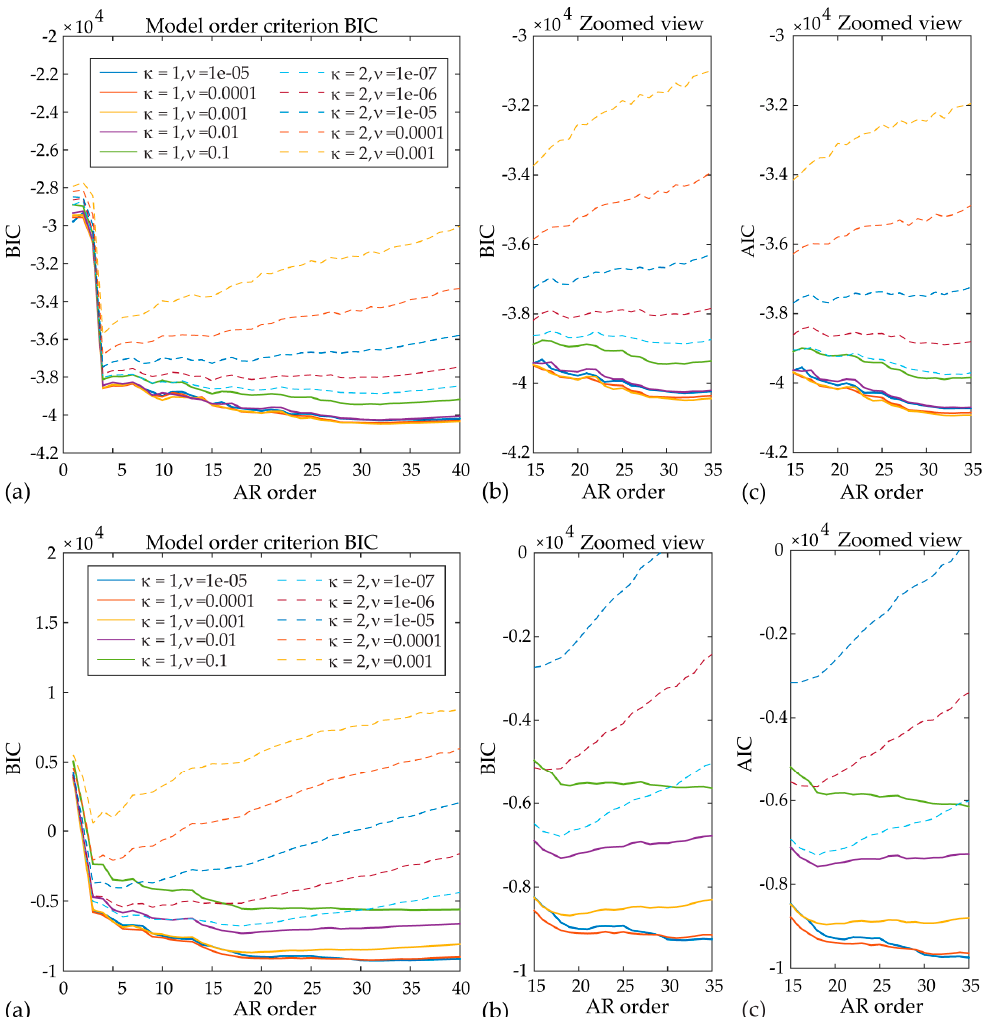
Figure 8. Statistical criterion for model order selection (Case A top and Case B bottom): ( a ) Bayesian statistical criterion; ( b ) Bayesian statistical criterion zoomed-in view; ( c ) Akaike statistical criterion zoomed-in view (For interpretation of the references to color, the reader is referred to the web version of this article).